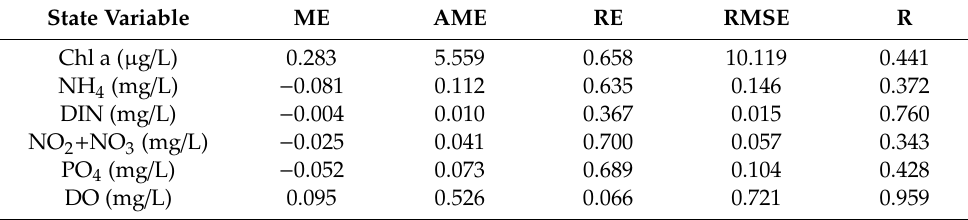
Figure 2. Taylor diagram displaying the statistical comparison of model predictions and observations of 13 monitoring stations of the dissolved oxygen, the monitoring station are James River (LE5.1, LE5.2, LE5.3, LE5.4, and LE5.5) and Elizabeth River (LE5.6, ELI2, EBE1, SBE2, SBE5, LFA01, LFB01, and WBE1). Table 2. A summary of statistics showing the skill of the James River water quality model